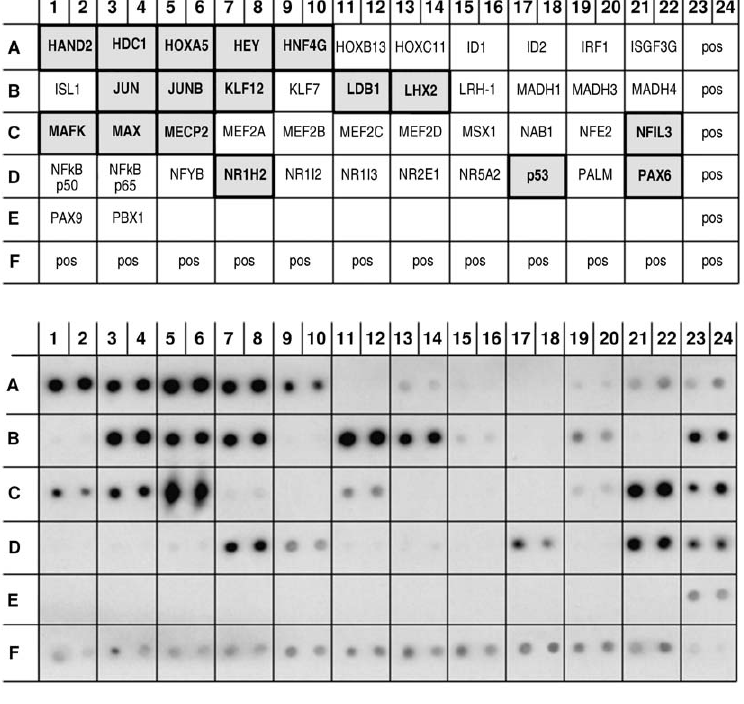
Figure 4. The Ankrd2 protein can interact with several transcription factors (TF). The upper panel is a schematic diagram of the Transcription Factor Array II (Panomics/Affymetrix, USA) showing the positions of the spotted His tagged TF proteins. The lower panel shows the TF protein-protein array membrane after probing with GST-Ankrd2 protein (15 m g/ml). The Ankrd2 protein bound very strongly to MeCP2 and strongly to HAND2, HDAC1, HOXA5, HEY, JUN, JUNB, KLF12, LDB1, LHX2, NFIL3 and PAX6. Weaker binding was seen with HNFG4, MAFK, MAX, NR1H2 and p53. The positive controls are at the bottom and right edge of the membranes. The TF proteins that interact with the Ankrd2 protein are highlighted.